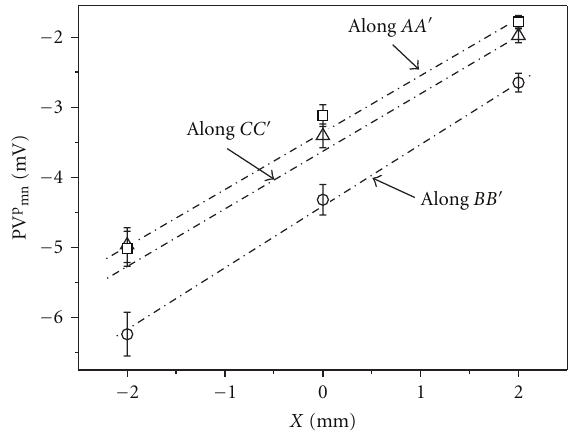
Figure 3: Dependence of the PV p mn on the position of the laser spot in the x direction when laser is irradiated on the ZnO